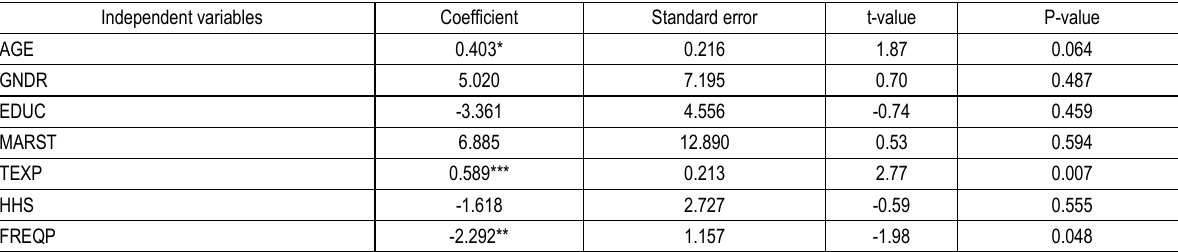
Table 8. Result of multiple regression